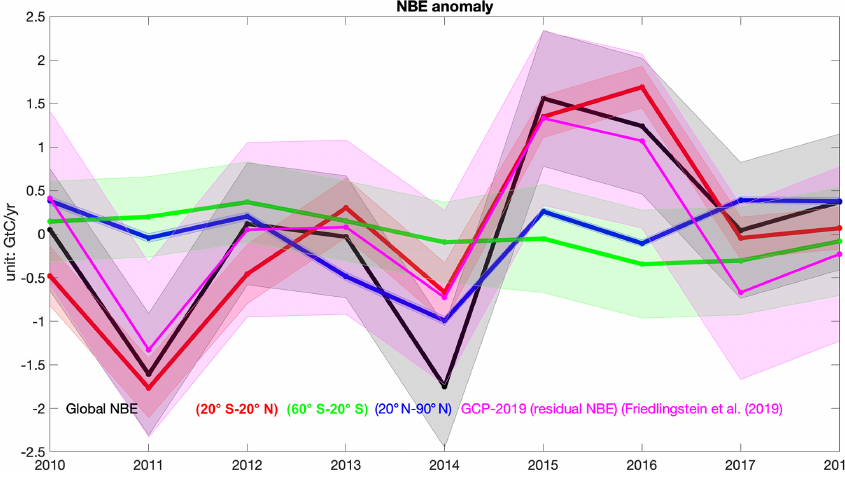
Figure 6. The NBE interannual variability over the globe (black), the tropics (20 ◦ S–20 ◦ N), SH midlatitudes (60–20 ◦ S), and NH midlat- itudes (20–90 ◦ N). For reference, the residual net land carbon sink from GCB-2019 (Friedlingstein et al., 2019) and its uncertainty is also shown